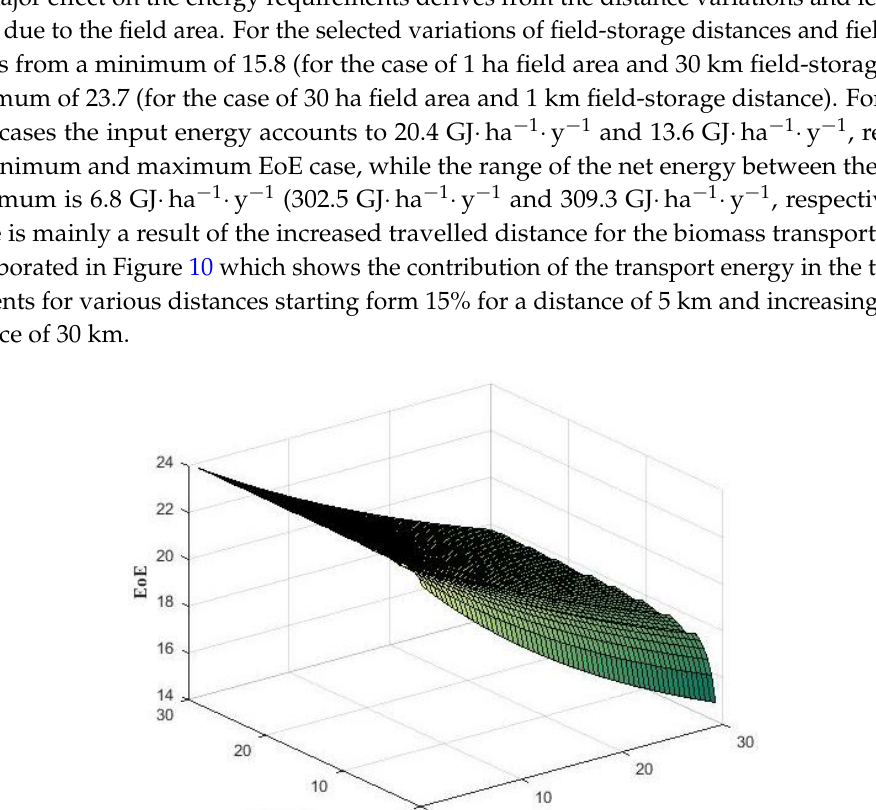
Figure 8. Energy contribution for the various field operations.